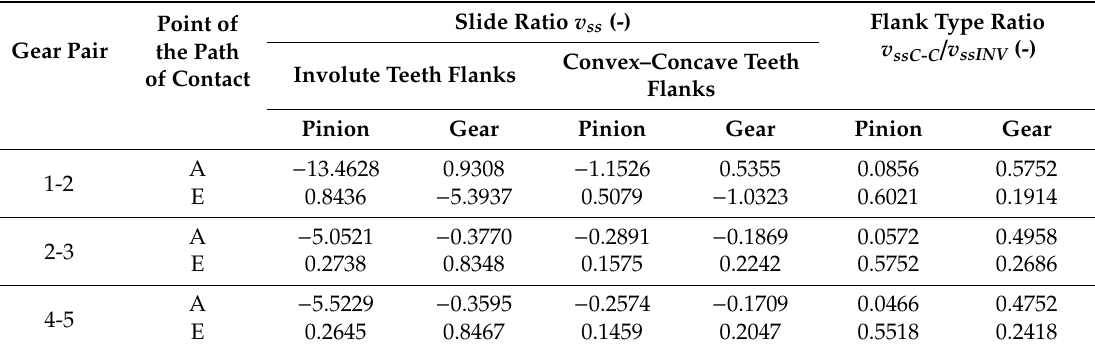
Table 4. Slide ratios of the partial gear pairs of the calculated gearbox.